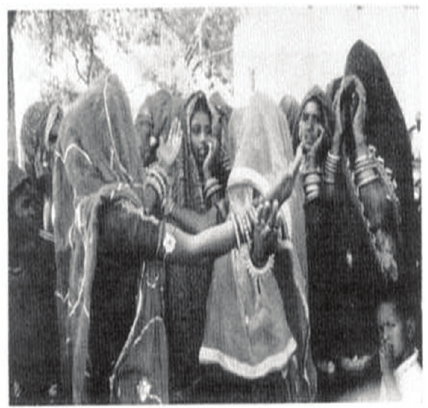
Figure 5: “Veil” custom (obsolete now): an old cultural practice in India in which face is kept hidden by a piece of cloth.